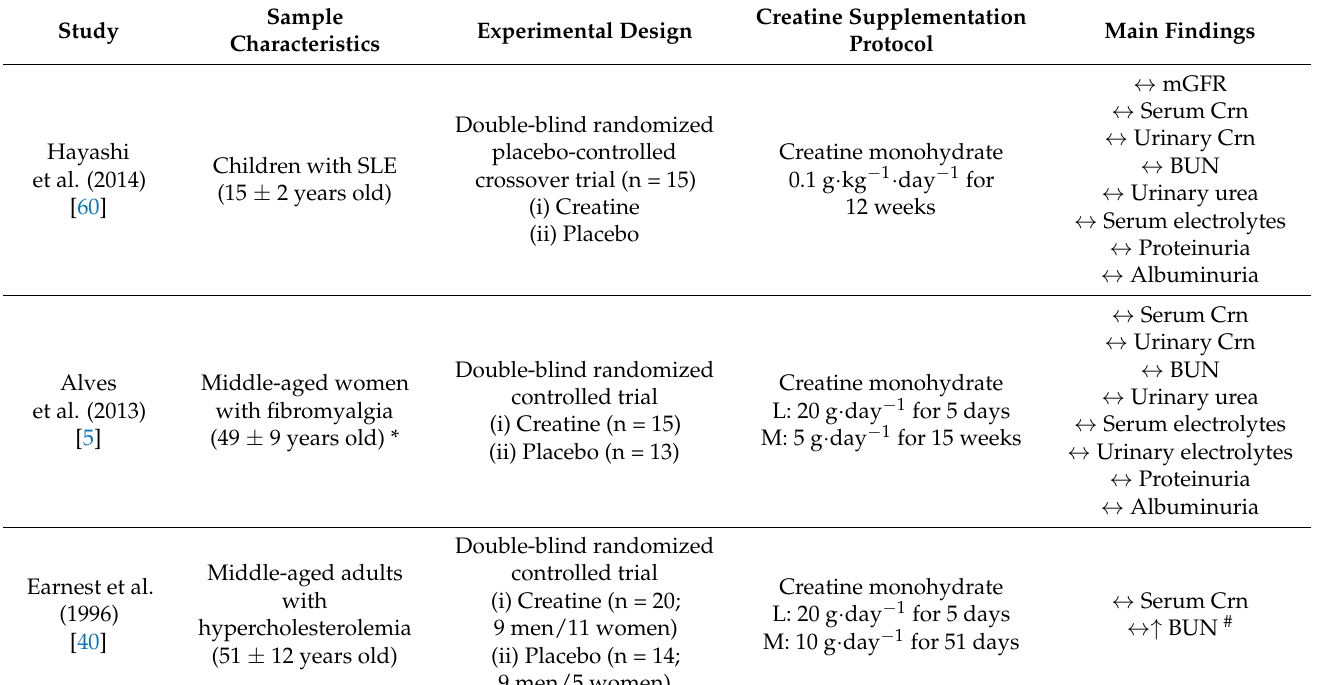
Table 4. Experimental studies investigating the effects of creatine supplementation on kidney function in clinical